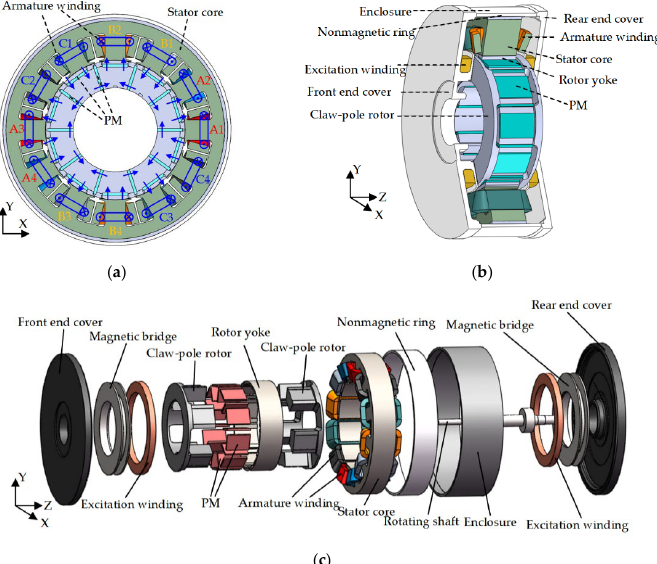
Figure 1. DHEG structure diagram: ( a ) Front view; ( b ) Section view; ( c ) Exploded view.